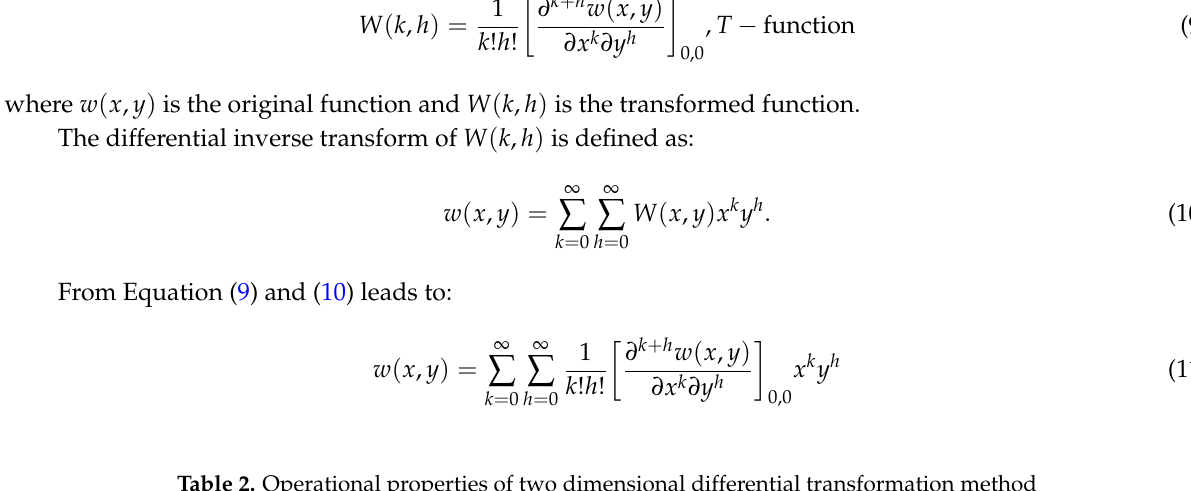
Table 2. Operational properties of two dimensional differential transformation